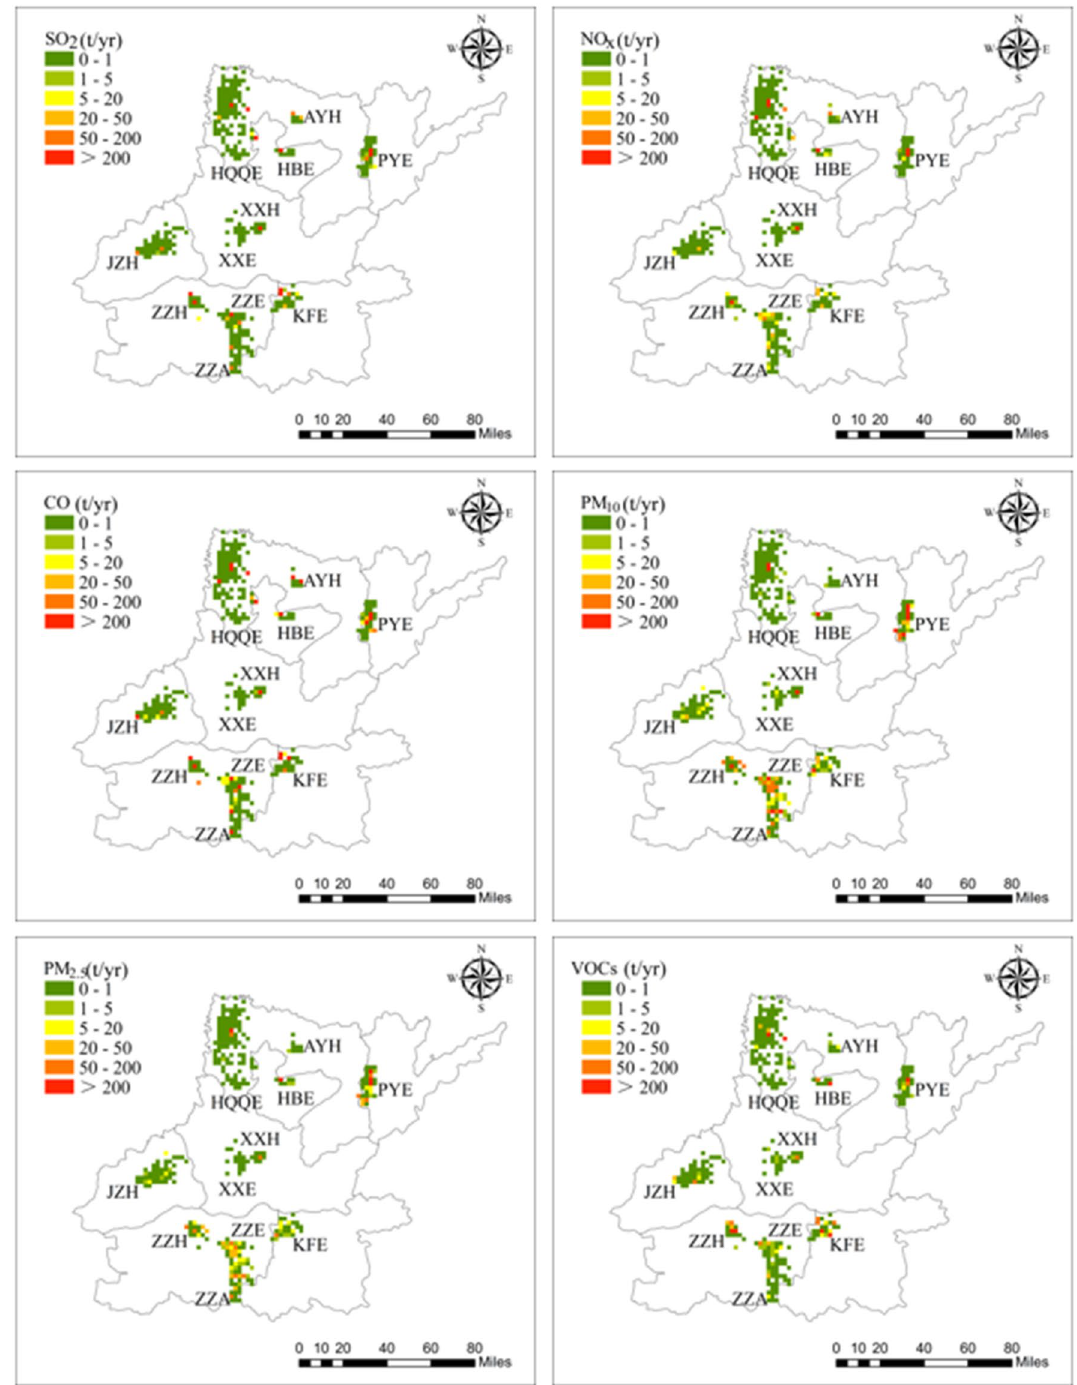
Figure 4. Gridded emissions of SO 2 , NO X , CO, PM 10 , PM 2.5 and VOCs at 3 km × 3 km resolution in 11 industrial parks of 2017. Map was created in ArcGIS Desktop v.10.2 software. (http:// www. esri. com/ softw are/ arcgis/ arcgis- for- deskt op/ free-